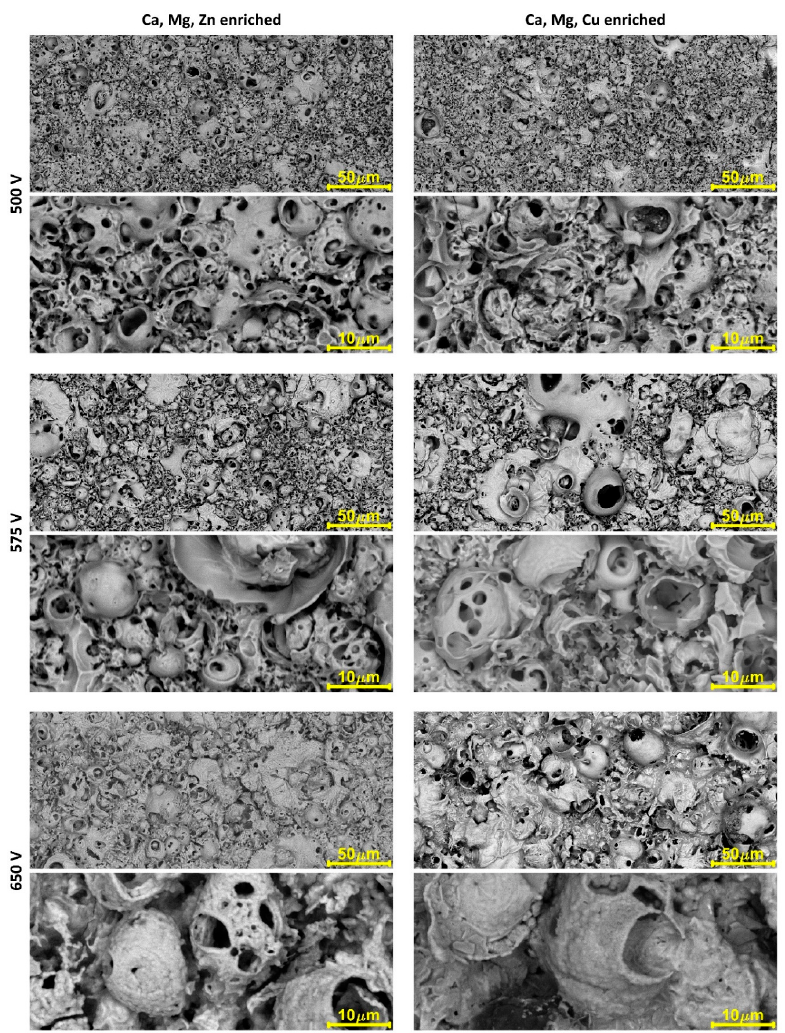
Figure 1. Surface morphologies of surfaces after PEO processing.